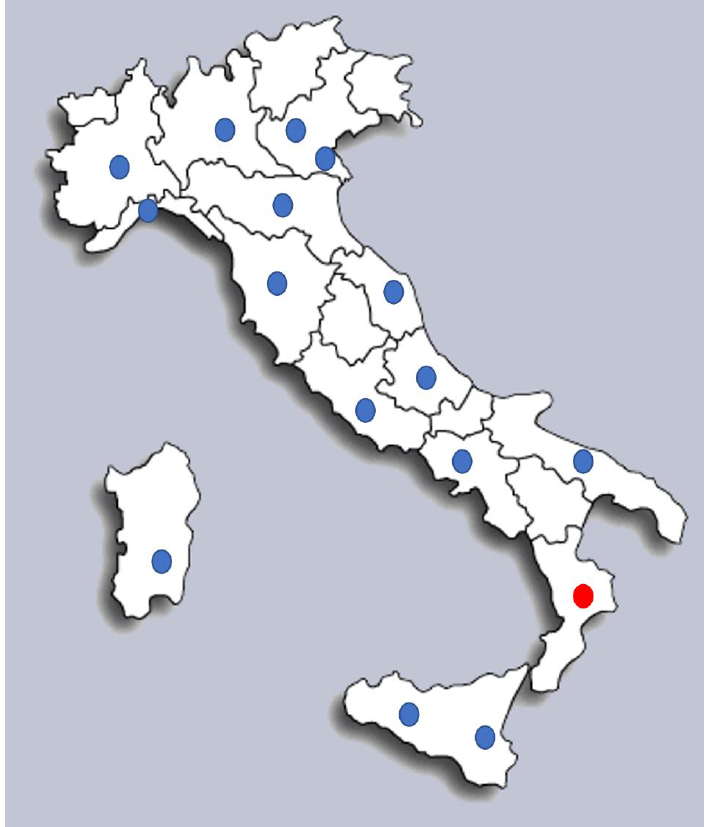
Figure 1. Map of Italian regions. The blue dots represent laboratories performing expanded Newborn Screening in Italy. The red dot marks the only regional laboratory not performing NBS tests by MS/MS in the years 2019–2020. Regions without a dot have established interregional agreements with neighboring region as described in paragraph 2.2 NBS Regional Organization and